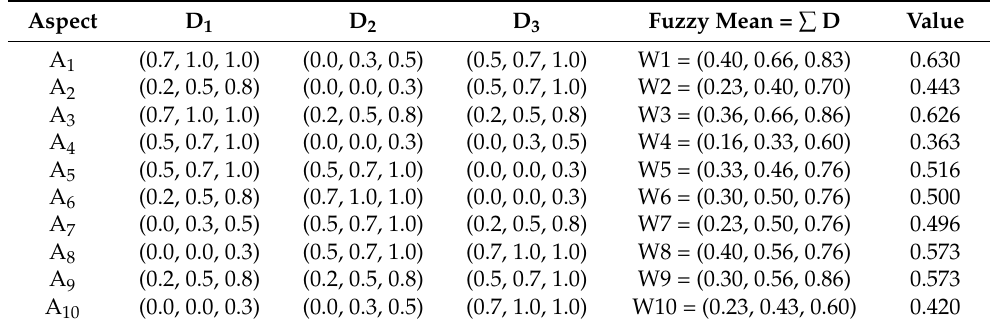
Table 8. Average linguistic rating for each aspect in the AMT implementation prediction